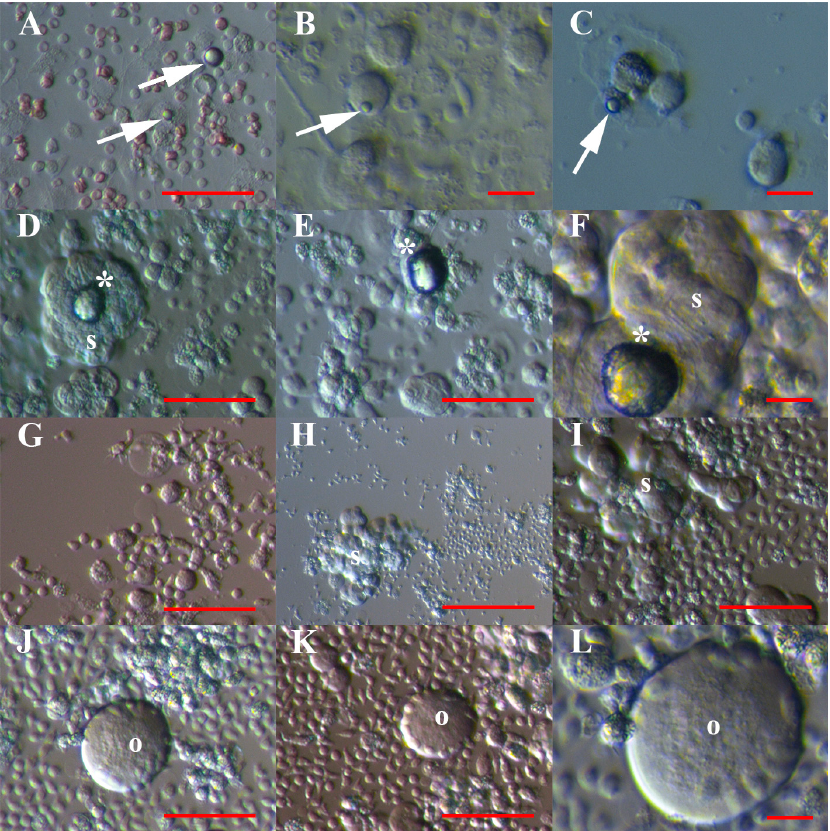
Figure 2. VSEL-like stem cells (arrows) with diameters of up to 5 μ m in cell cultures from recurrent ovarian cancer ascites. ( A – C ) VSEL-like stem cells among other types of cells in a cell culture; ( D – F ) VSEL-like stem cells forming cell clusters (asterisks) attached to spheroids; ( G – I ) highly proliferating VSEL-like stem cells growing into larger cells and forming spheroids; and ( J – L ) highly proliferating VSEL-like stem cells growing into larger, oocyte-like cells. Inverted microscope (Hoffman illumination). Legend: s—spheroid; o—oocyte-like cell. Red bar: 10 μ m for B, C, F, L; 50